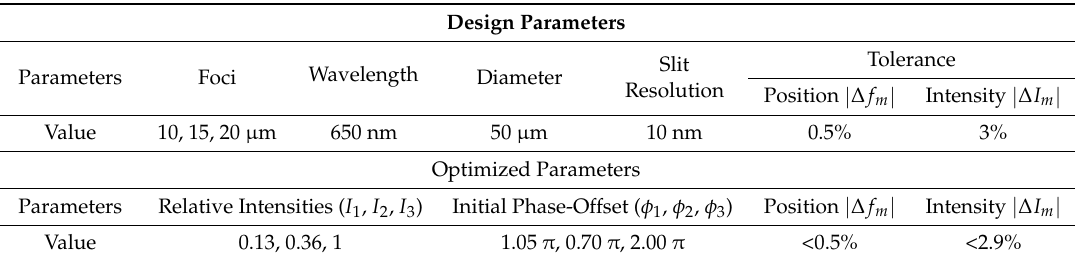
Table 1. Simulation parameters for a monochromatic, multi-focal